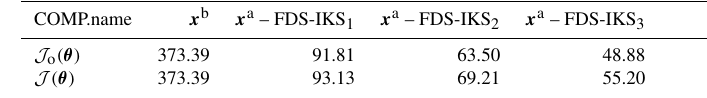
Table B1. CESM parameter estimation: convergence of FDS-IKS cost function.